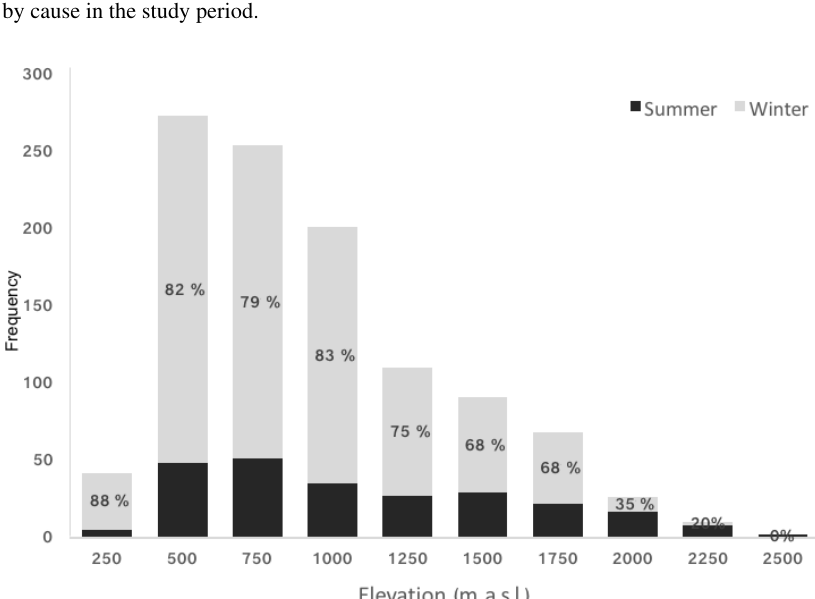
Figure 6. Absolute and relative frequency of summer (black) vs. winter (grey) fire ignitions in the study area by elevation